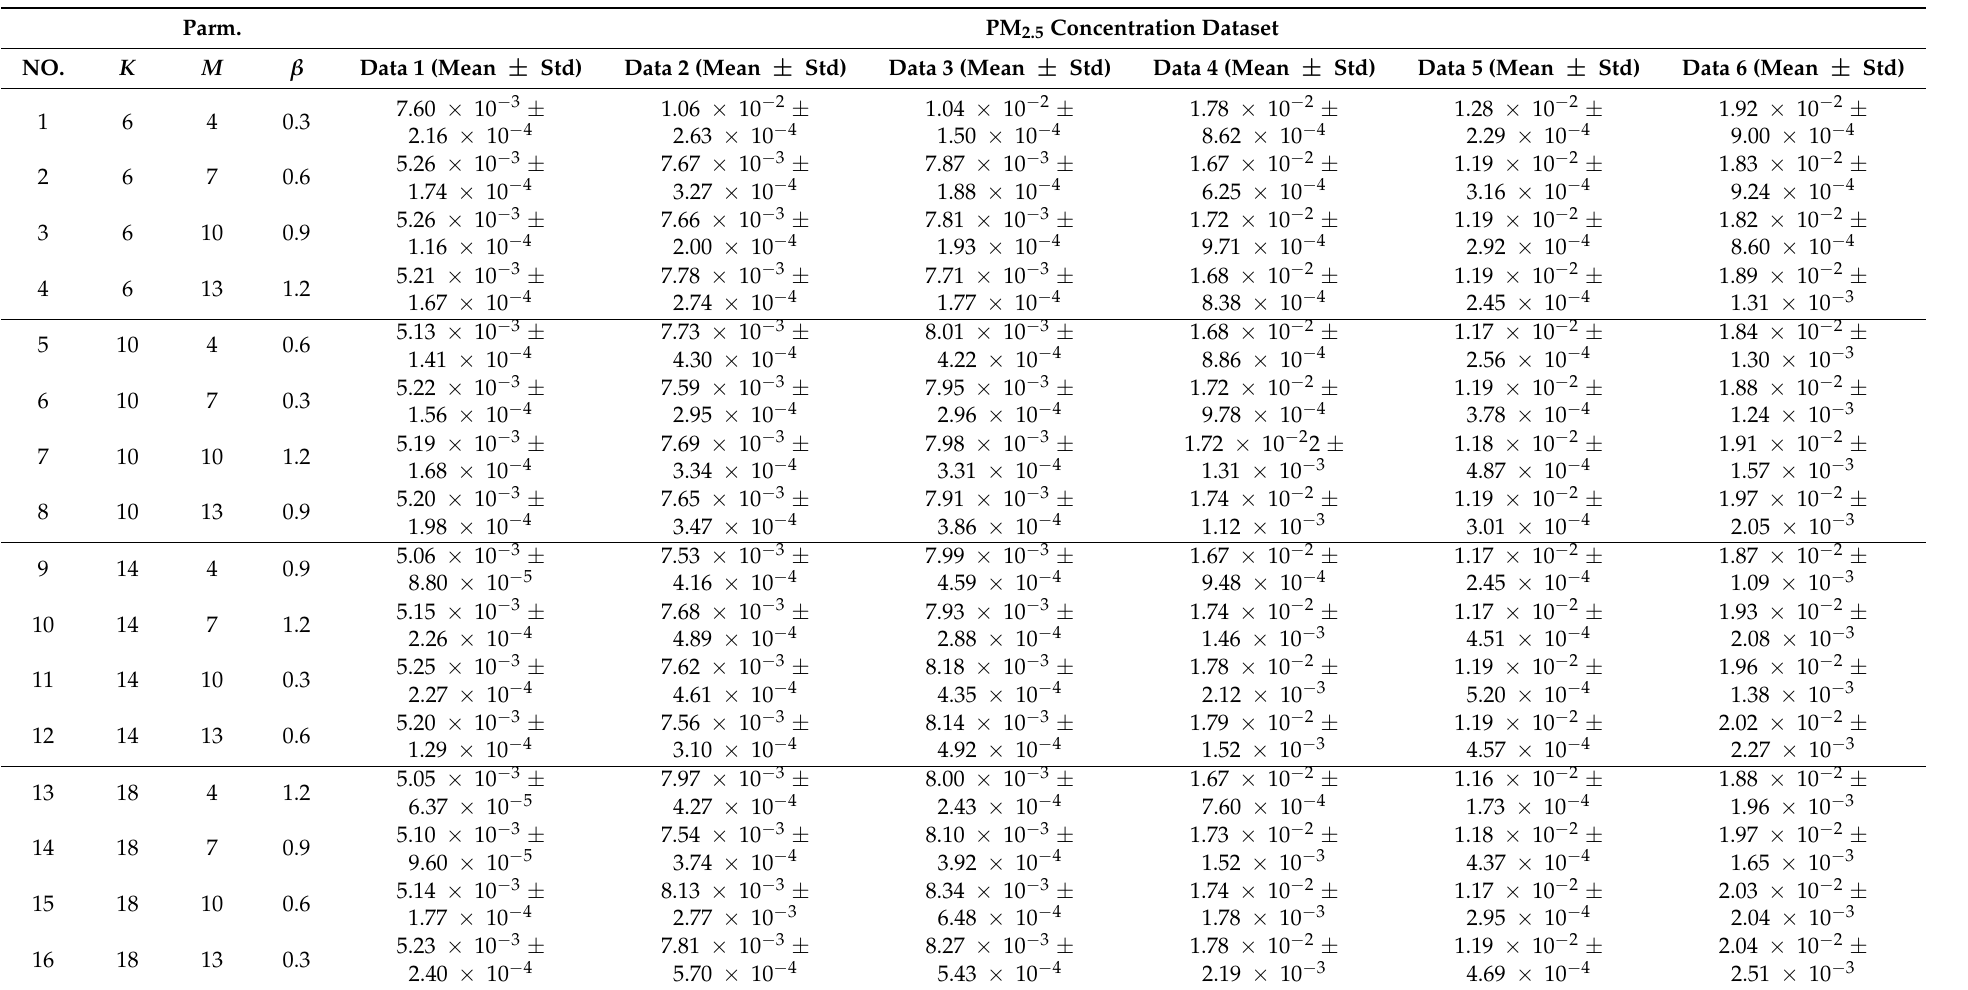
Table 4. Experimental results of the SDNN for the PM 2.5 concentration data and different parameter combinations.